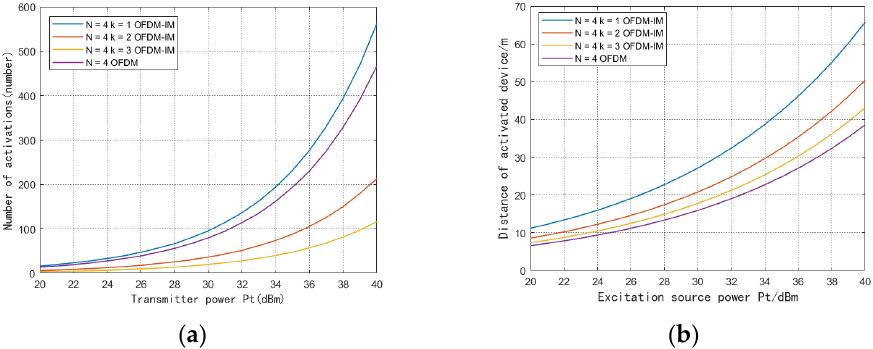
Figure 5. ( a ) Number of activations of di ff erent power devices at the transmi tt er. ( b ) Activation distance of di ff erent power devices at the transmi tt er.